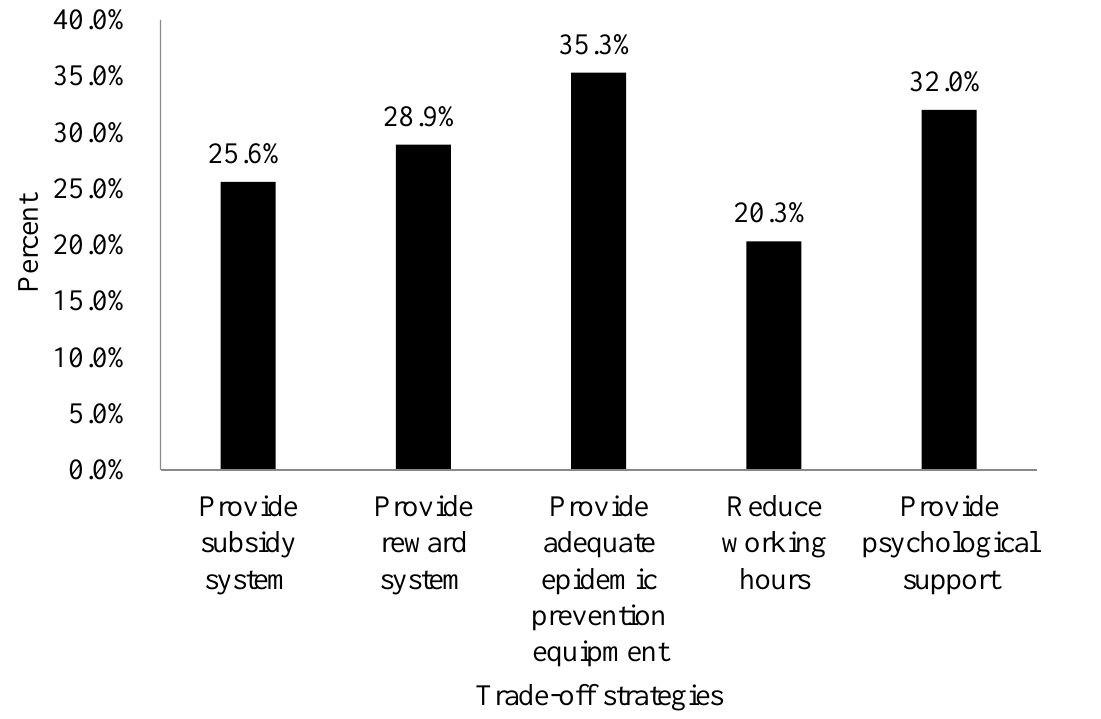
Figure 1. Willingness to provide care to patients with COVID-19 under different trade-off conditions ( n = 266).